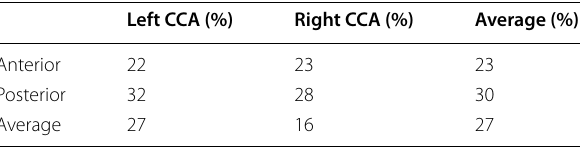
Table 2 Coefficient of variation of the anterior, posterior, right, and left